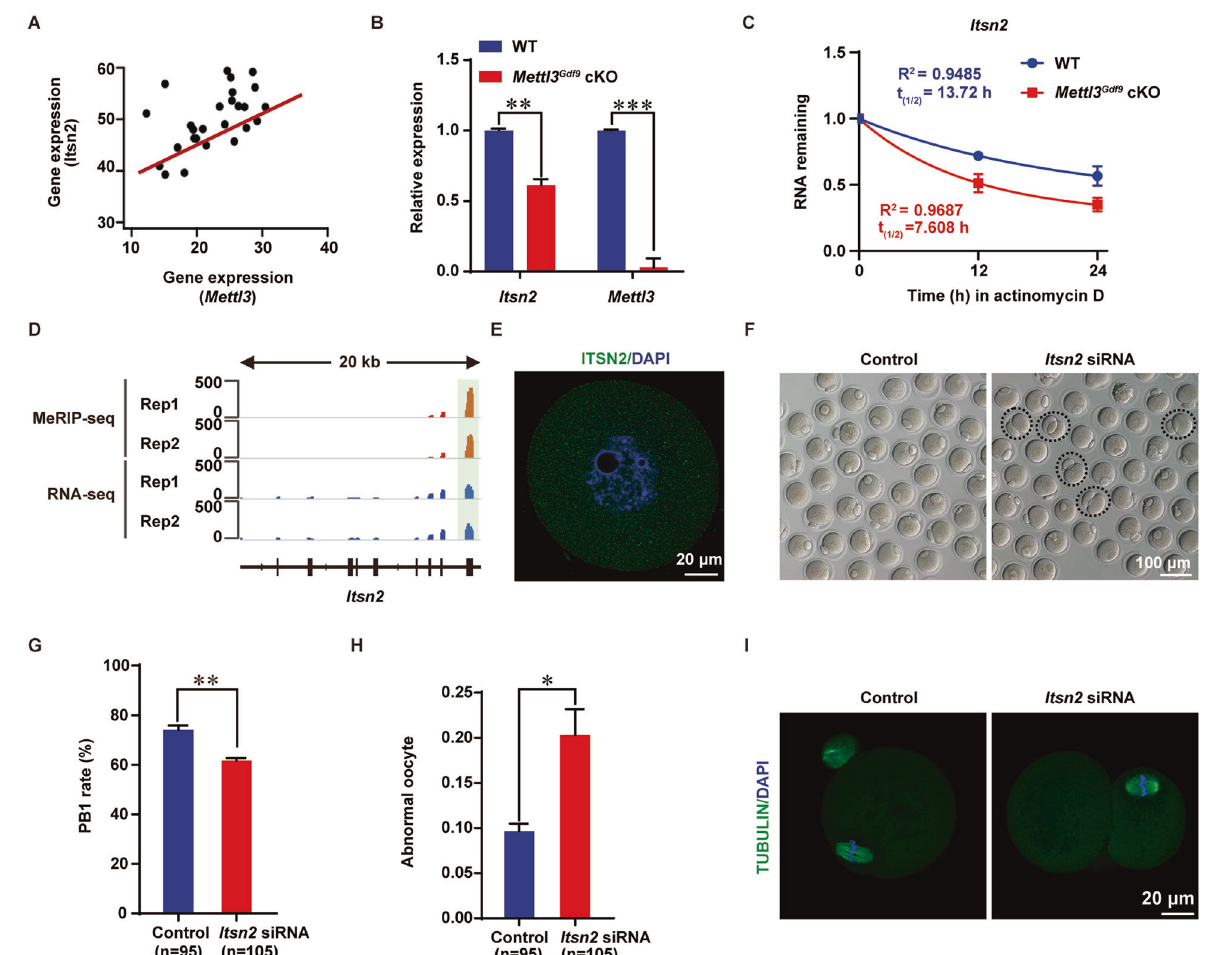
mice. The relative mRNA levels of Itsn2 and Mettl3 in WT oocytes were set to 1.0. ** p < 0.01; *** p < 0.001 by two-tailed Student ’ s t -test. Data represent the mean ± SEM ( n = 3). C q RT-PCR analysis of Itsn2 mRNA stability in growing oocytes of WT and Mettl3 Gdf9 cKO mice. Data were presented as means ± SEM, n = 3. D Integrated genomics viewer (IGV) plot showing the m 6 A peak across Itsn2 mRNA transcript; the green box represents the m 6 A peak identi fi ed by MeRIP-seq. E Confocal immuno fl uorescence staining for ITSN2 (green) in oocytes. DAPI was used to stain nuclei (blue). Scale bar, 20 μ m. F Images of control siRNA (Control) and Itsn2 siRNA microinjected oocytes. Dashed circles indicate oocytes with big polar body or symmetrical division. Scale bar, 100 μ m. G , H Rates of PB1 formation and abnormal oocytes after Itsn2 siRNA and control siRNA (Control) microinjection. Control siRNA microinjected oocytes, n = 95; Itsn2 siRNA microinjected oocytes, n = 105. * p < 0.05; ** p < 0.01 by two-tailed Student ’ s t -test. Data represent the mean ± SEM ( n = 3). I Confocal immuno fl uorescence staining with α -Tubulin antibody (green) and DAPI (blue) for Itsn2 siRNA and control siRNA microinjected oocytes. Scale bar, 20 μ